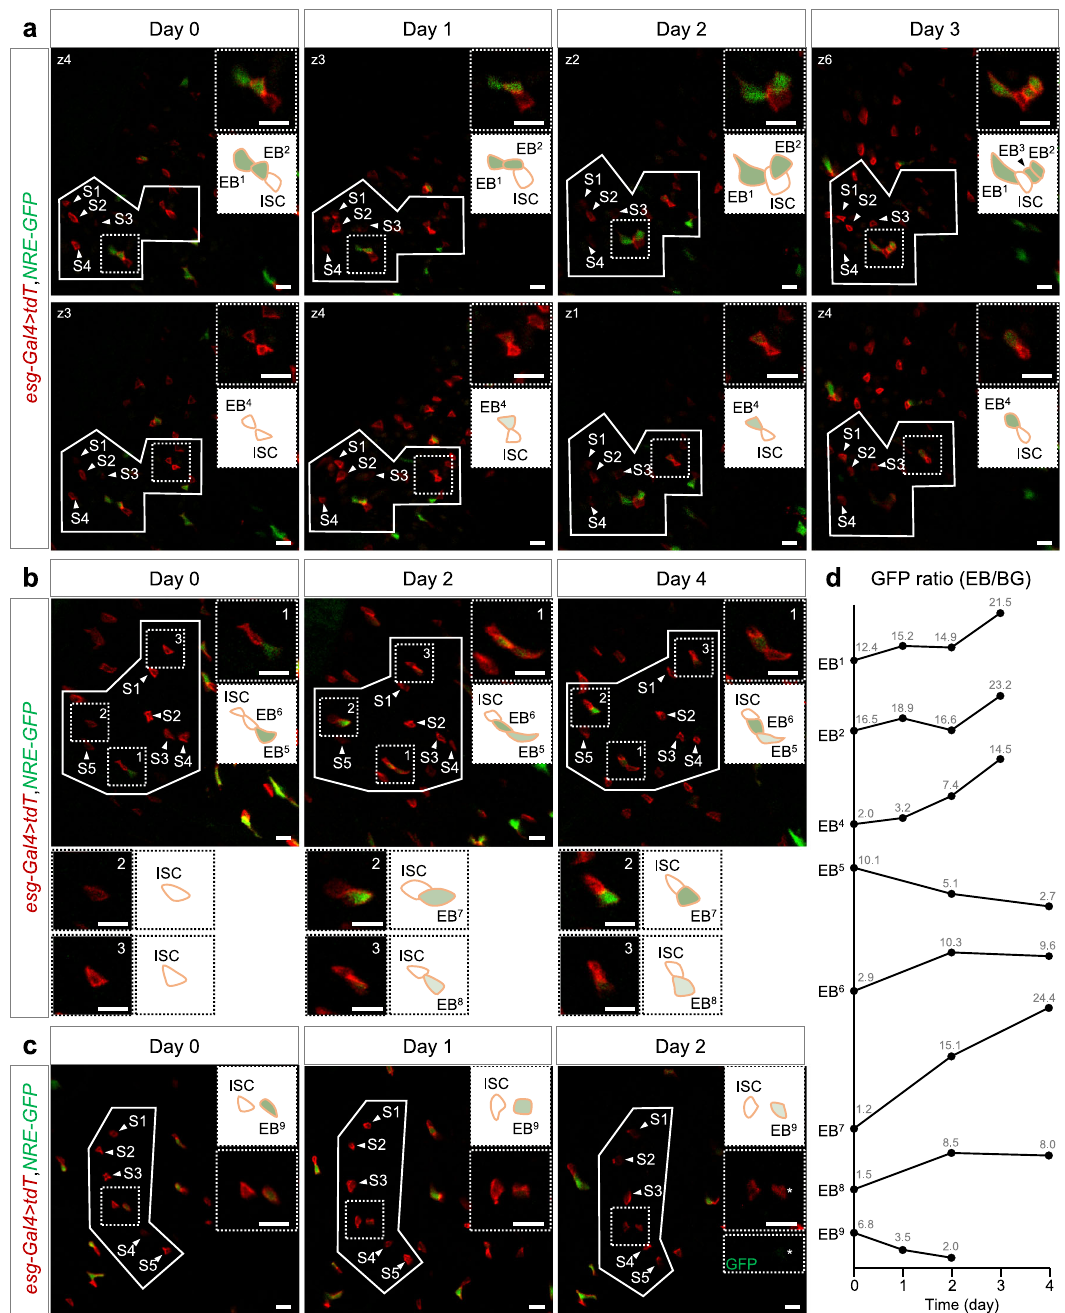
Fig. 4 Intravital tracking of quiescent ISCs and “ differentiation-poised ” EBs in the intestines of young and healthy fl ies. a Detection of ISCs and EBs over 3 days with the interval of 1 day. A distinctive cell pattern (solid line) formed by four ISCs (S1-S4, white arrowheads) was re-identi fi ed over time. An ISC-EB-EB cluster (ISC, EB 1 , and EB 2 , dashed square in the fi rst panel) and an ISC-EB pair (ISC and EB 4 , dashed square in the second panel) were analyzed at two individual z-sections. Newborn EB 3 were identi fi ed at day 3. Magni fi cation and schematic illustration inside the dashed squares are shown in the upper right corner. b Detection of ISCs and EBs over 4 days with the interval of 2 days. An ISC-EB-EB cluster (ISC, EB 5 , and EB 6 , dashed box1) and two single ISCs (dashed box2 and box3) were detected using the pattern of ISCs (S1 – S5). Newborn EB 7 and EB 8 were identi fi ed at day 2. Magni fi cation and schematic illustration inside the dashed squares are displayed in the upper right corner and lower panels. c Detection of ISCs and EBs over 2 days with the interval of 1 day. A putative ISC-EB pair (ISC and EB 9 , dashed box) was detected using the pattern of ISCs (S1 – S5). NRE-GFP in EB 9 (white asterisk) was still visible at day 2. Magni fi cation and schematic illustration inside the dashed squares are shown in the upper right corner. Genotype in all images: esg-Gal4 10×UAS-myr:tdTomato, NRE-GFP . All scale bars in a – c are 10 μ m. d The quanti fi cation of GFP ratio for EBs from a – c (except for EB 3 ). Measurement of the GFP fl uorescence intensity of an EB and its surrounding BG, and Notch activity at different time points were normalized using the “ signal-to-noise ” ratio.